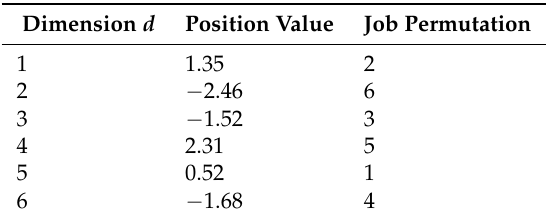
Table 1. Example of the smallest position value (SPV) approach.